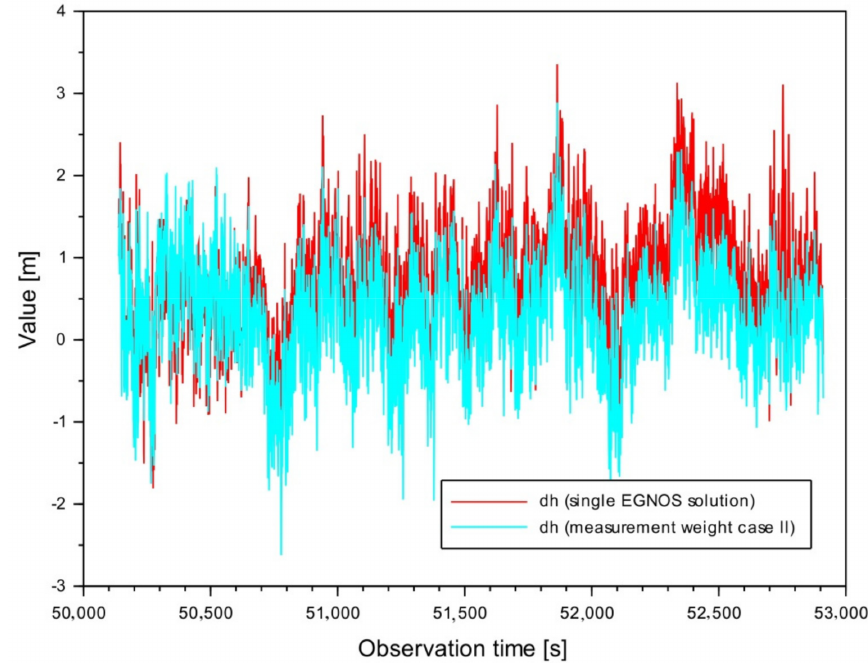
Figure 17. Results of position errors dh from the weighted mean model (Case II) and single EG- NOS